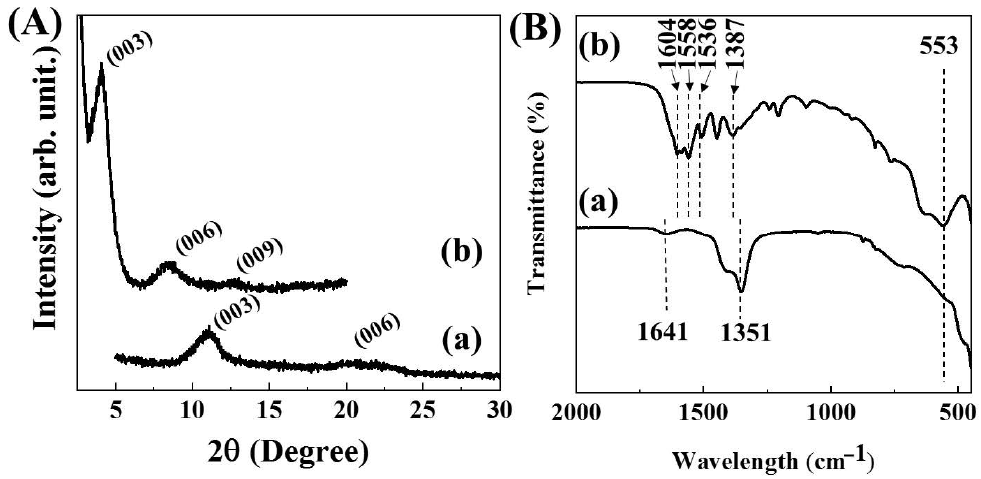
Figure 1. ( A ) X-ray diffraction patterns and ( B ) Fourier-transform infrared spectra for (a) MgAl-NO 3 -layered double hydroxide (LDH) and (b) methotrexate (MTX)-LDH. The XRD patterns were focused on the low angle region to highlight (00l) patterns.